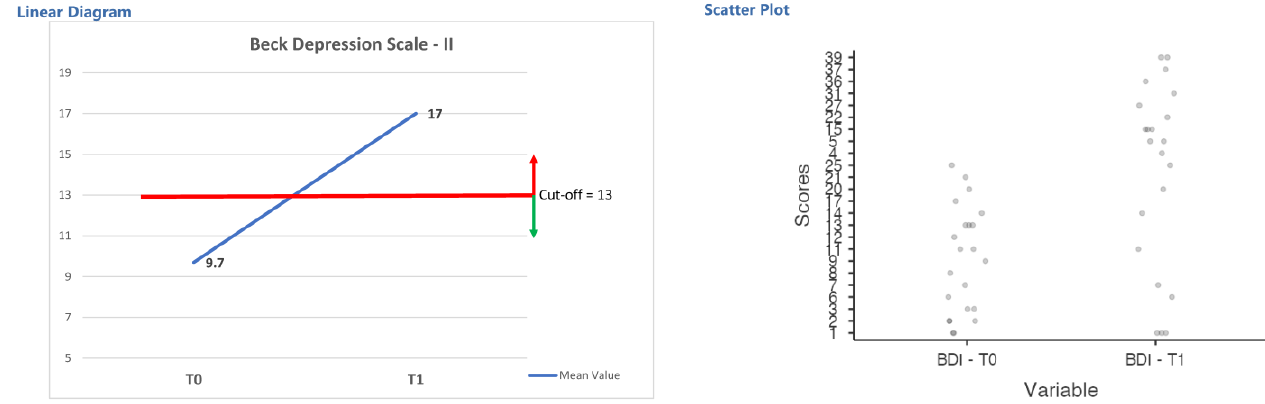
Figure 5. Diagram of test-retest evaluation and scatter plot of depression measure for Research Protocol 2. Table 5. I-CADS raw score of sample after chemotherapy treatment and t -test one